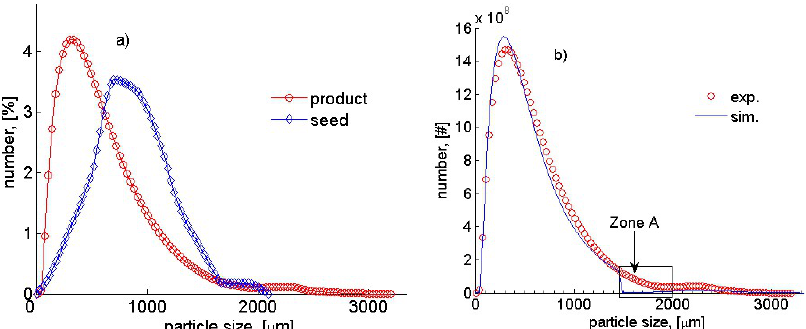
Figure 6. CSDs of seeds according to the crystal length ( a ) and width ( b ).